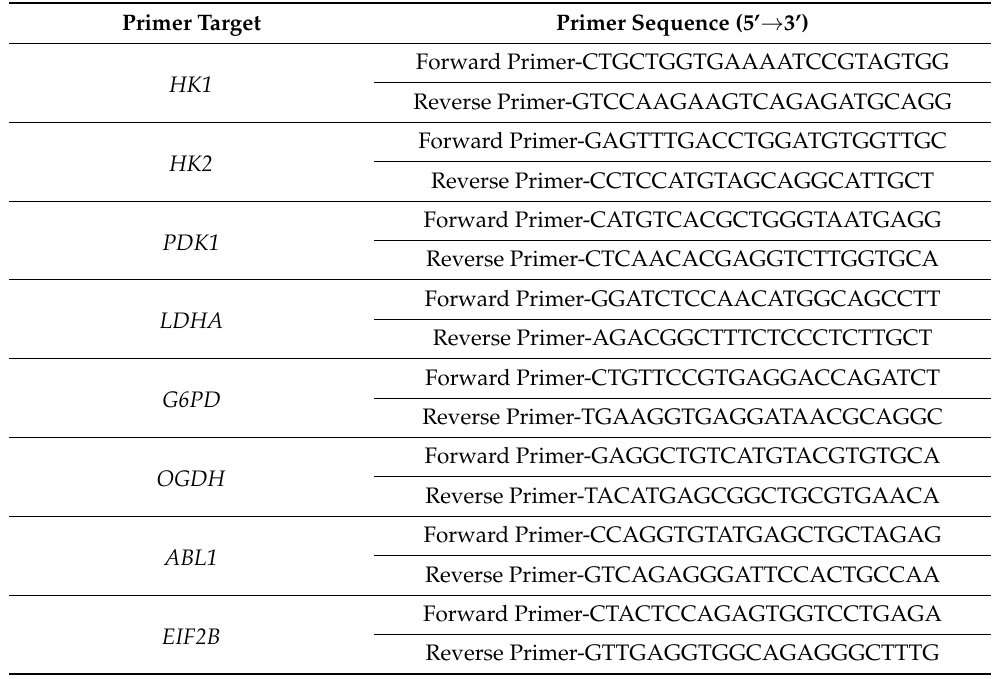
Table 2. The primer sequences for RT-PCR analysis of the expression of metabolic genes. Primer